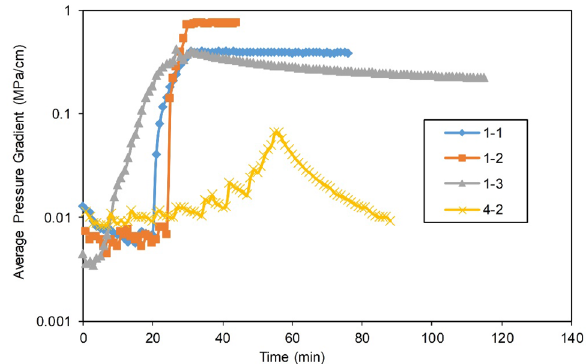
Figure 11. Average pressure gradients at different times in the near-wellbore zone of the Group I.